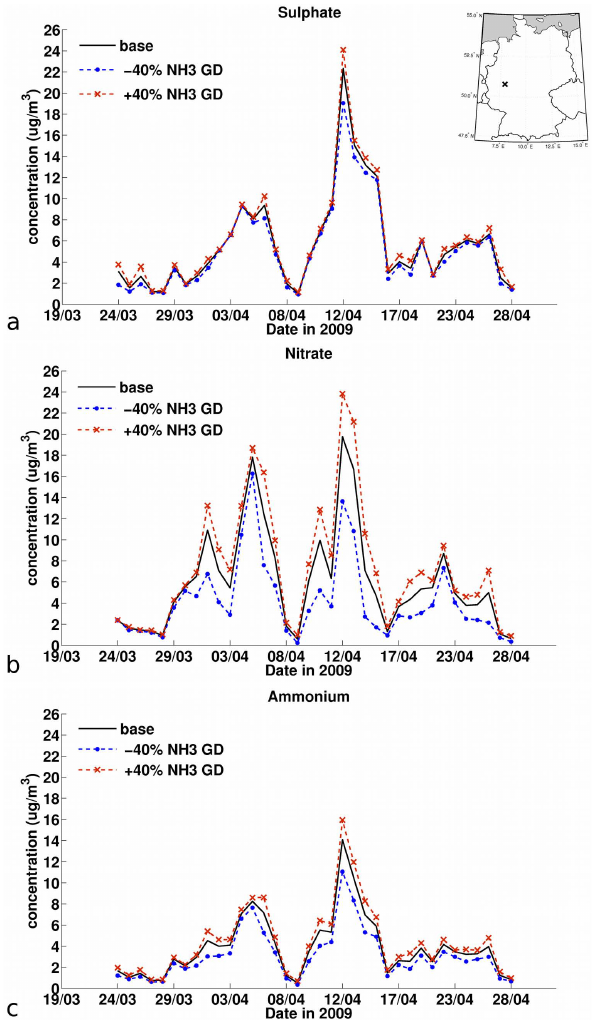
Fig. 9. Daily mean (a) sulfate, (b) nitrate and (c) ammonium con- centration at station Westerwald-Herdorf for different ammonia emission scenario